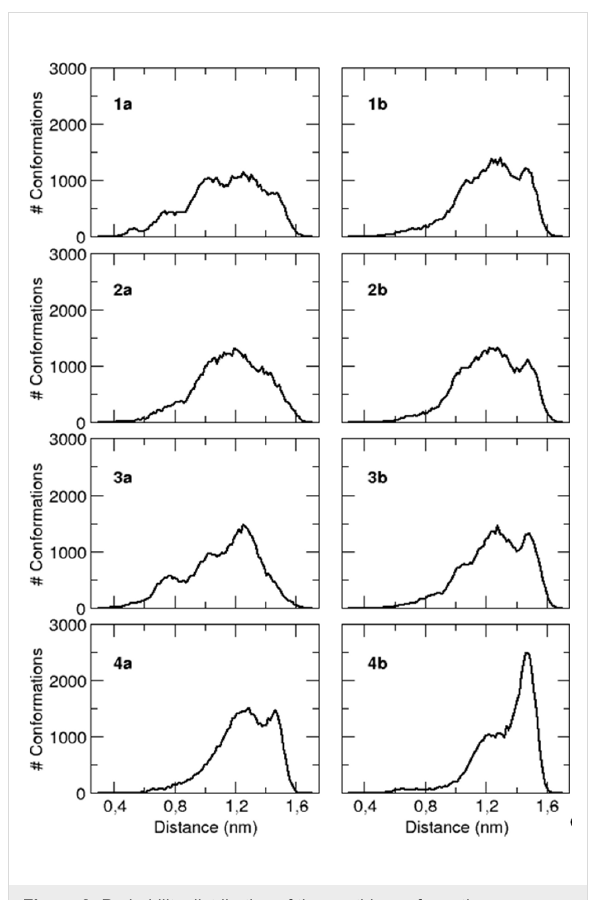
Figure 2: Probability distribution of the peptide conformations as a function of end-to-end distance (defined as the distance between the nitrogen of residue Ala 1 and the carbon of the C -terminal